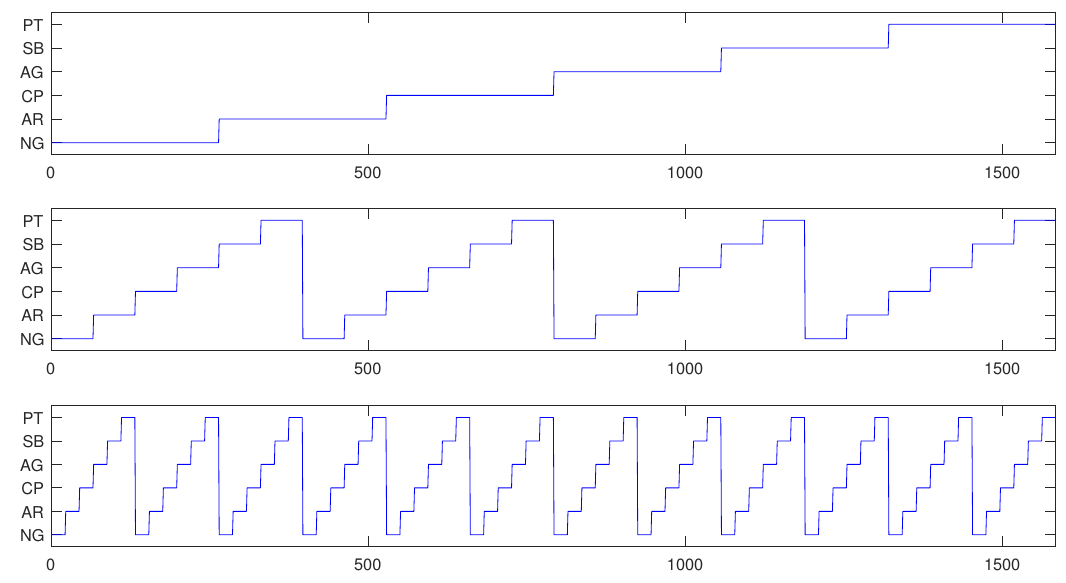
Figure 6. Sampled terrain sequences with different dwelling times. From top to bottom, each terrain dwells for 264, 66 or 22 sampling points, respectively. X axis represents sampling